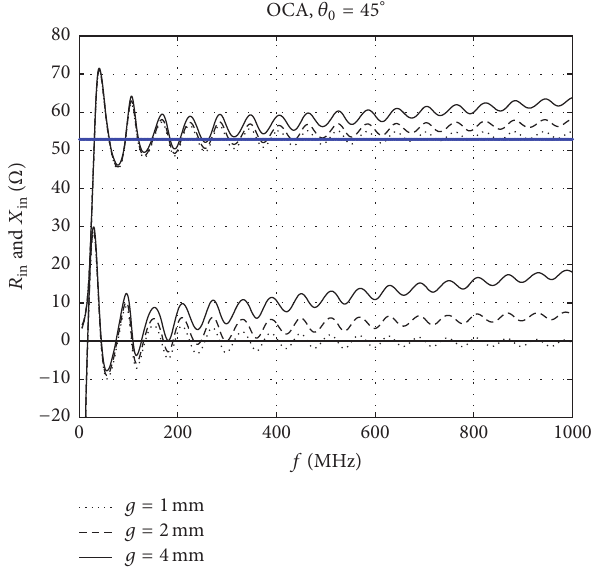
Figure 24: 𝑆 11 of the OCA for 3 different gap lengths, 𝜃 0 = 15 ∘ and Ω . 𝑍 𝑟 = 50